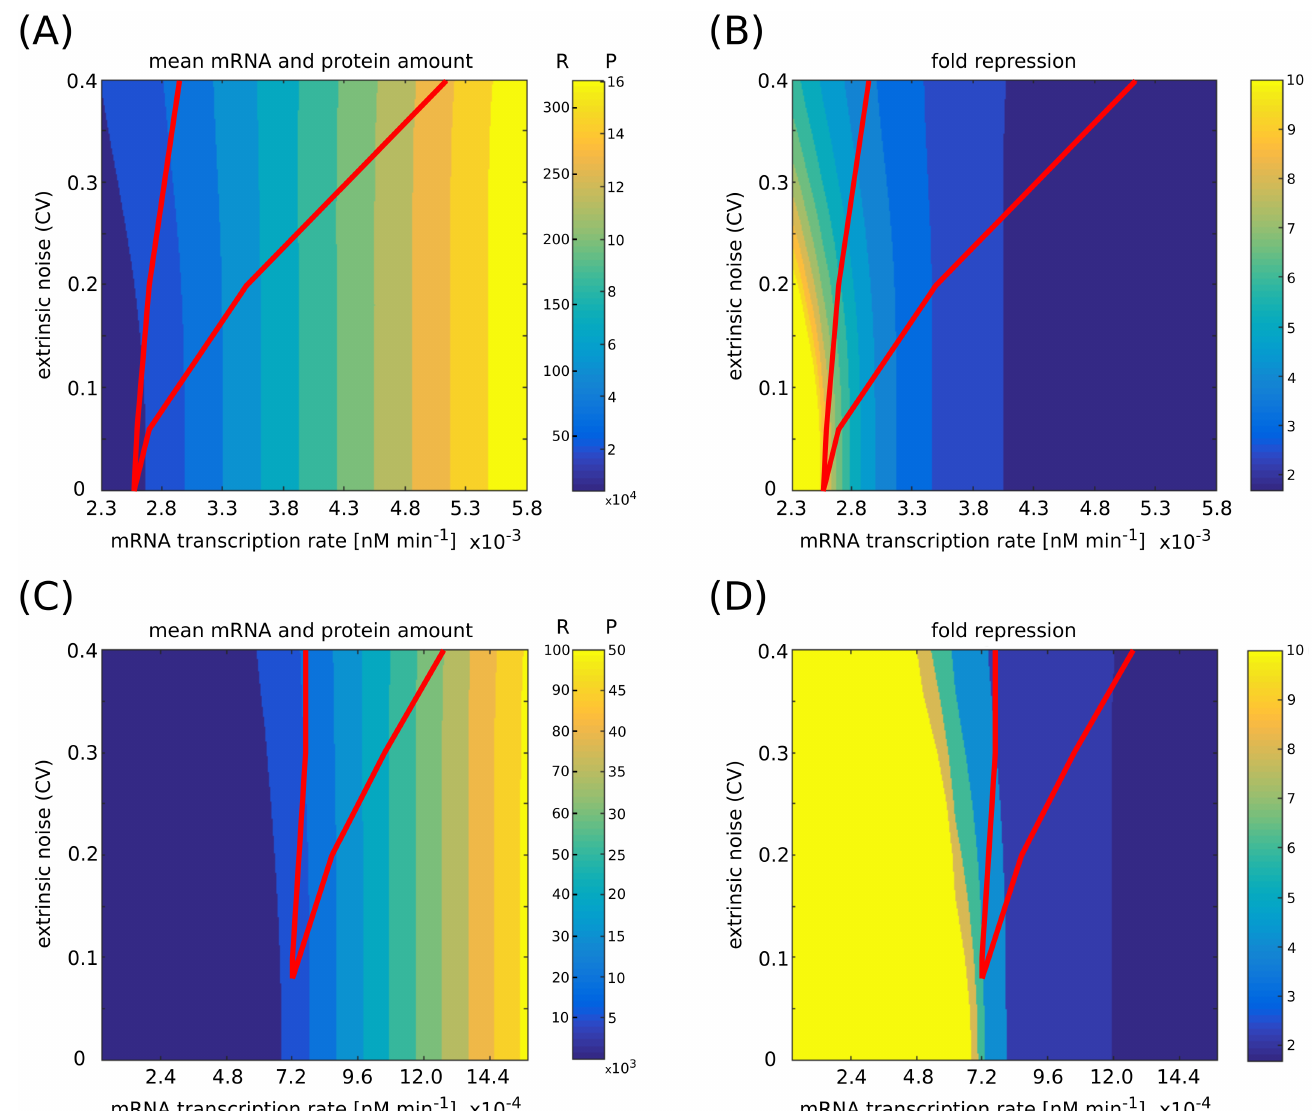
Fig 7. Mean molecules amounts and fold repression. (A,C) Mean mRNA free amount (R) and protein amount (P) for two different sets of parameters, as a function of mRNA transcription rate and extrinsic noise level. The red line indicates the bimodality region. (B,D) Fold repression, i.e. ratio between the unregulated and regulated expression level, as a function of mRNA transcription rate and extrinsic noise level. The red line indicates the bimodality region. Mean values and fold repression are computed through the analytic approximation, while the bimodality region is obtained from numerical simulations. The set of parameters of panels (C) and (D) resembles an endogenous scenario, where the mean values of free mRNAs are of order of tens and the fold repression ranges between 2 and 6. In (A) and (B) the parameters are: g S = 1.2 × 10 −2 min −1 , g R = 2.4 × 10 −2 min −1 , k P = 6.0 min −1 , g P = 1.2 × 10 −2 min −1 , g = 3.0 × 10 2 nM −1 min −1 , α = 0.5. Target mRNA transcription rate ranges from k R = 2.3 × 10 −3 nM min −1 to k R = 5.8 × 10 −3 nM min −1 . Extrinsic noise is tuned by varying the standard deviation of the distribution with mean (cid:22) k ¼ 1 : 2 (cid:2) 10 (cid:0) 3 nM min (cid:0) 1 from which miRNA transcription rates are picked. The amount of free miRNAs in this regime is of the order of tens, while S its total amount (measured as the ratio between its transcription and degradation rates) is 250 molecules per cell. In (C) and (D) the parameters are: g S = 1.2 × 10 −2 min −1 , g = 2.4 × 10 −2 min −1 , k = 6.0 min −1 , g = 1.2 × 10 −2 min −1 , g = 3.0 × 10 2 nM −1 min −1 , α = 0.8. Target mRNA transcription rate ranges from k = 0 nM R P P R min −1 to k R = 1.5 × 10 −3 nM min −1 . Extrinsic noise is tuned by varying the standard deviation of the distribution with mean (cid:22) k ¼ 4 : 8 (cid:2) 10 (cid:0) 4 nM min (cid:0) 1 from S which miRNA transcription rates are picked. The amount of free miRNAs in this regime is of the order of tens, while its total amount is 100 molecules per cell.